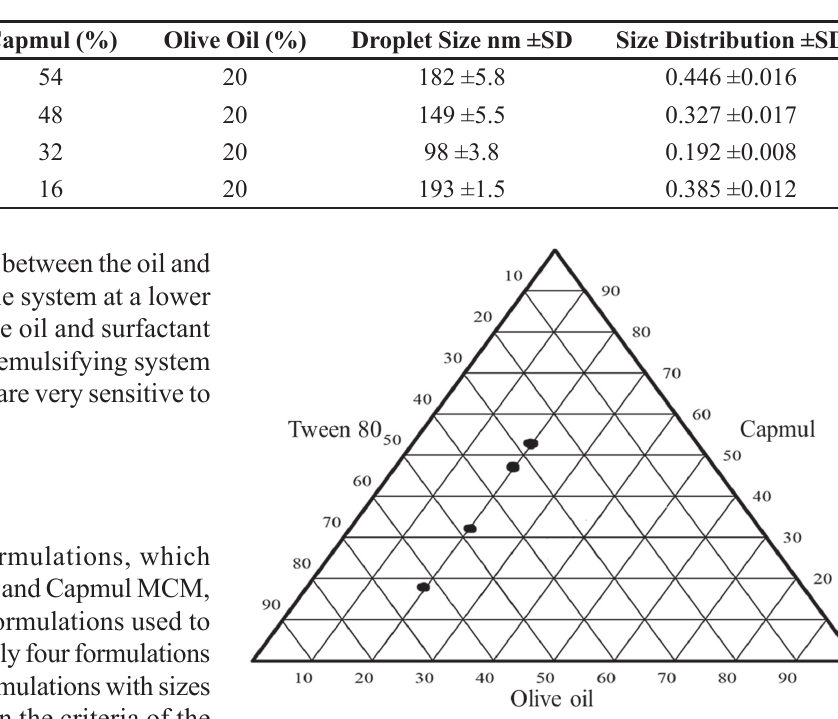
FIGURE 2 - The selected Self-nanoemulsifying formulations on the ternary phase TABLE II - Visual observation of the self-nanoemulsifying formulations